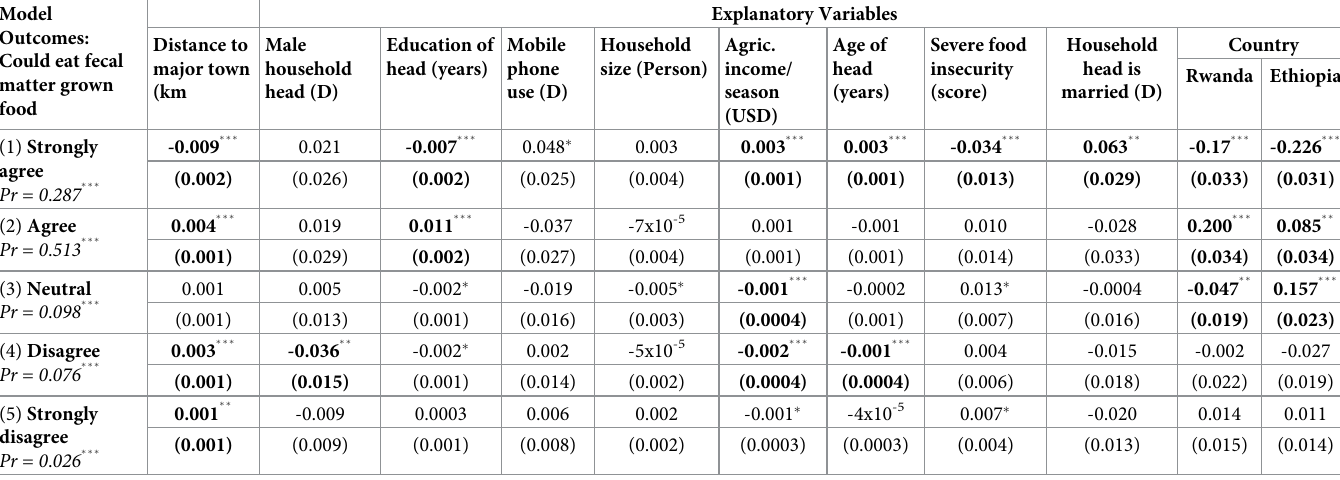
Table 10. Marginal effects after generalized ordered logit on eating foods grown on faecal matter. Model Outcomes: